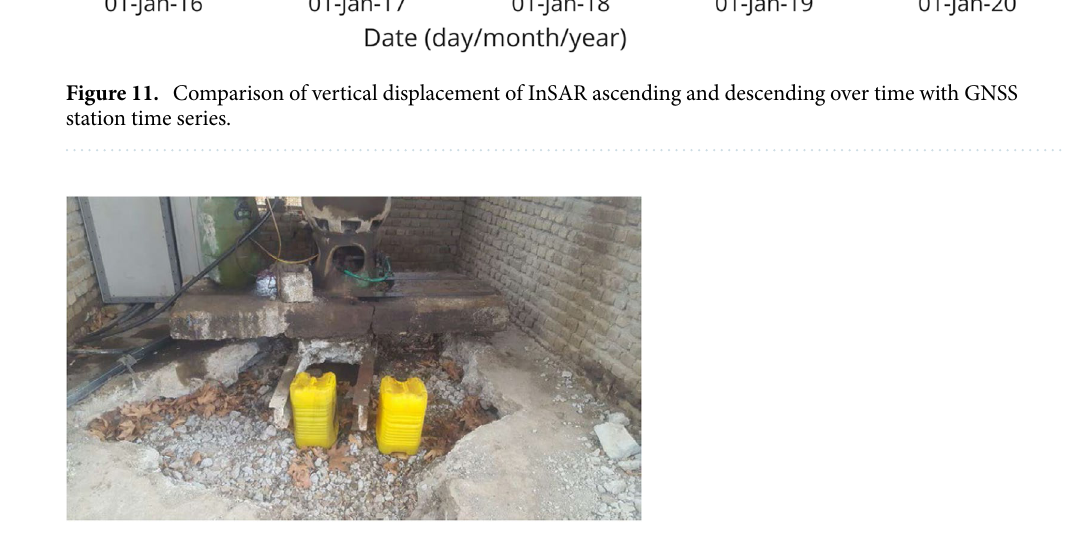
Figure 12. Visible offset of well pipe from the ground surface in Hashtgerd plain which shows a clear subsidence of the ground 52